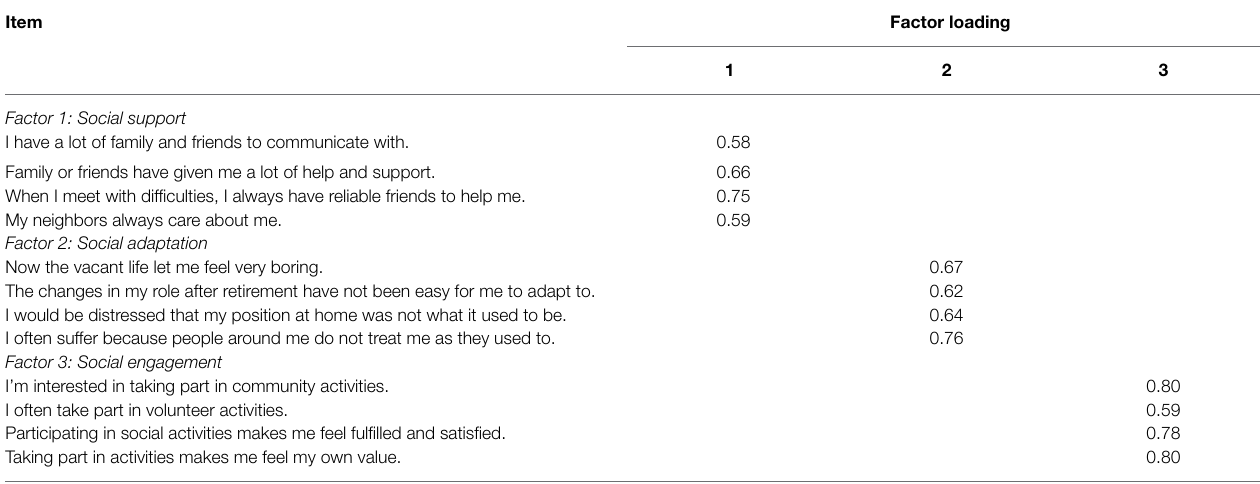
TABLE 4 | Factor loadings for the 12-item model ( n = 1,714).